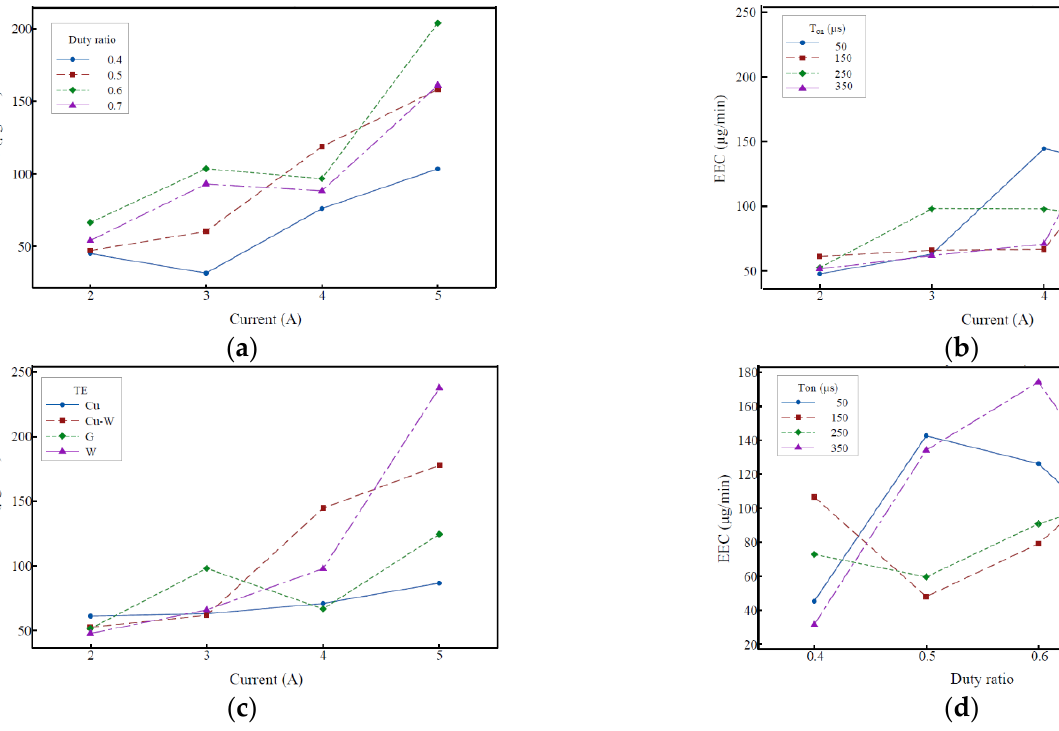
Figure 12. Interaction effect on EEC; ( a ) current and duty ratio on EEC; ( b ) current and pulse duration on EEC; ( c ) current and tool electrode on EEC; ( d ) duty ratio and pulse duration on EEC.